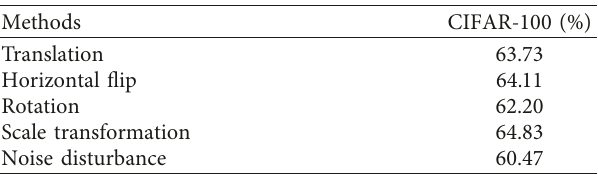
Table 4: Classification accuracy of various data augmentation methods on CIFAR-100 under the proposed full stage data aug- mentation framework.